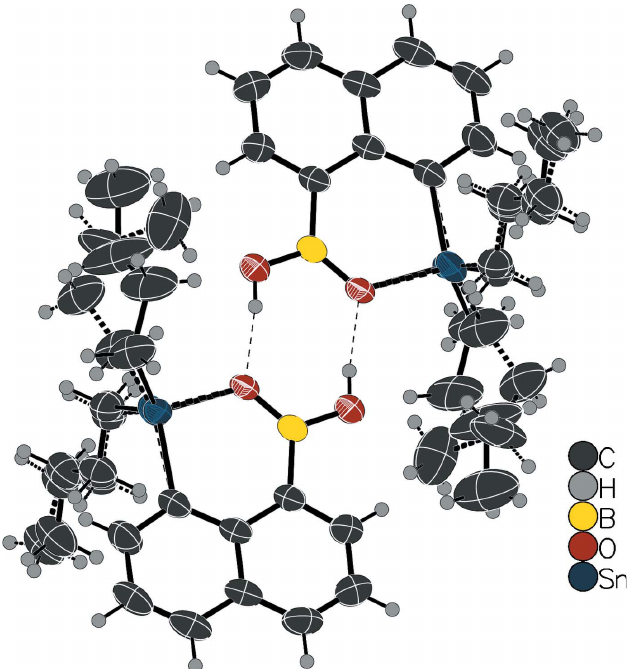
Figure 3 Structure of the dimer formed through hydrogen bonding. Displacement ellipsoids are drawn at the 50% probability level. Hydrogen atoms are drawn as fixed-size spheres with a radius of 0.15 A˚